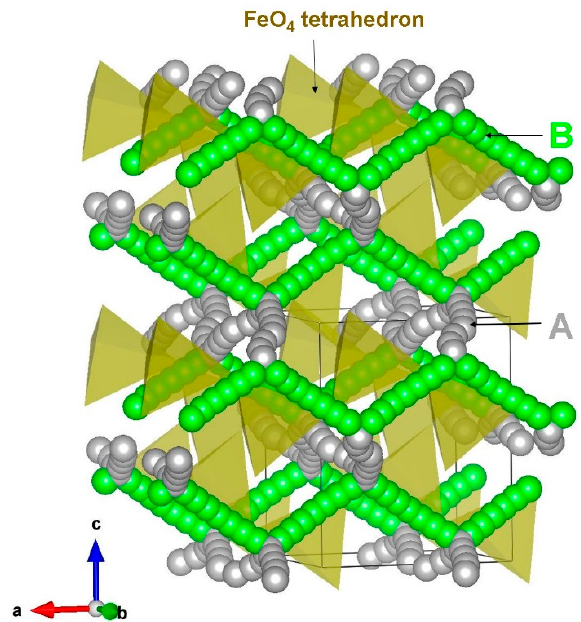
Figure 4. Possible long range sodium vacancy migration paths considered in β -NaFeO 2 . Local Na migration paths are shown in green and grey atoms.